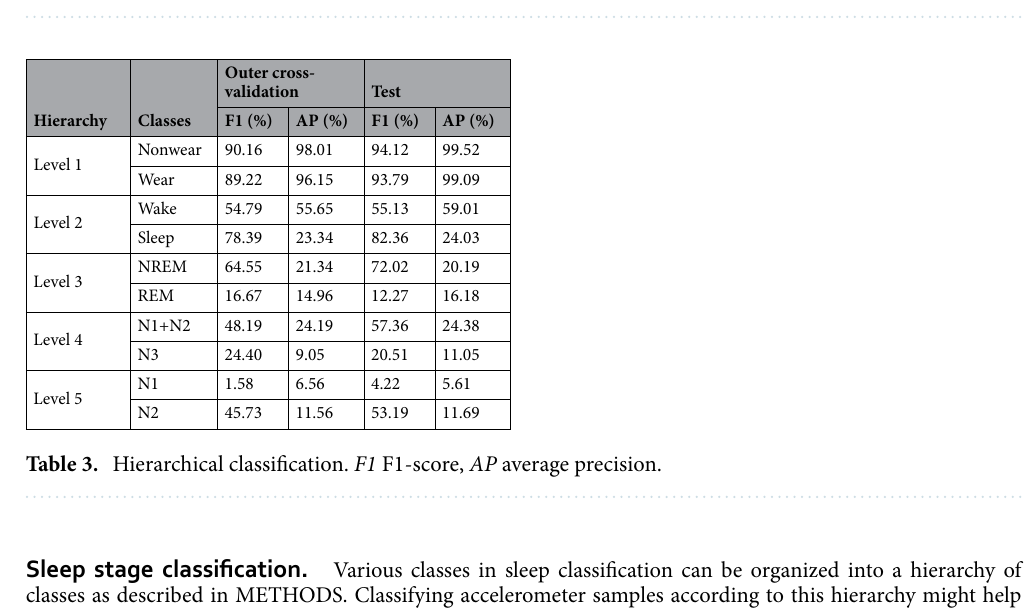
Figure 2. Sleep-wake performance random forests for healthy and poor sleepers (difference for wake and sleep is 11.28 ( p = 0.0031 ) and 5.57 ( p = 0.0018 ), respectively).